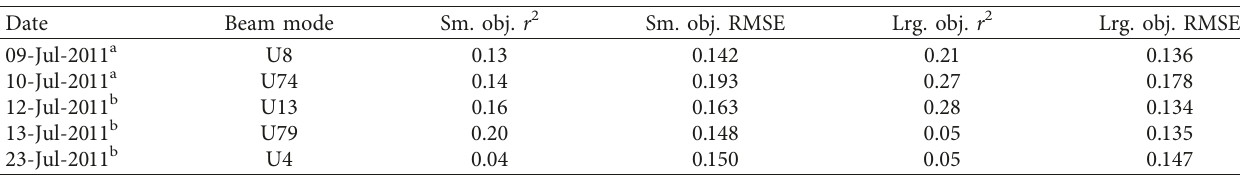
Table 4: r 2 and RMSE values of the ANN applied to the different scenes/dates at Cape Collingwood in 2011. Date Beam mode